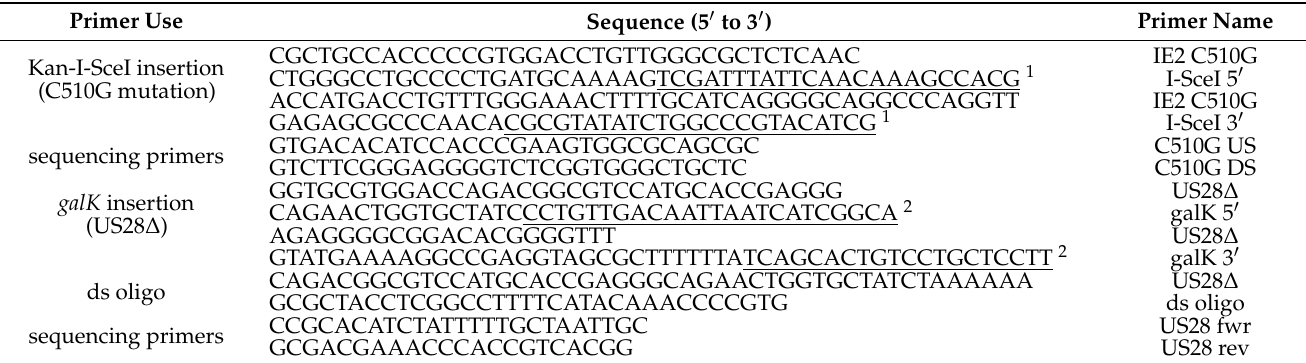
Table 1. Oligonucleotides used in this